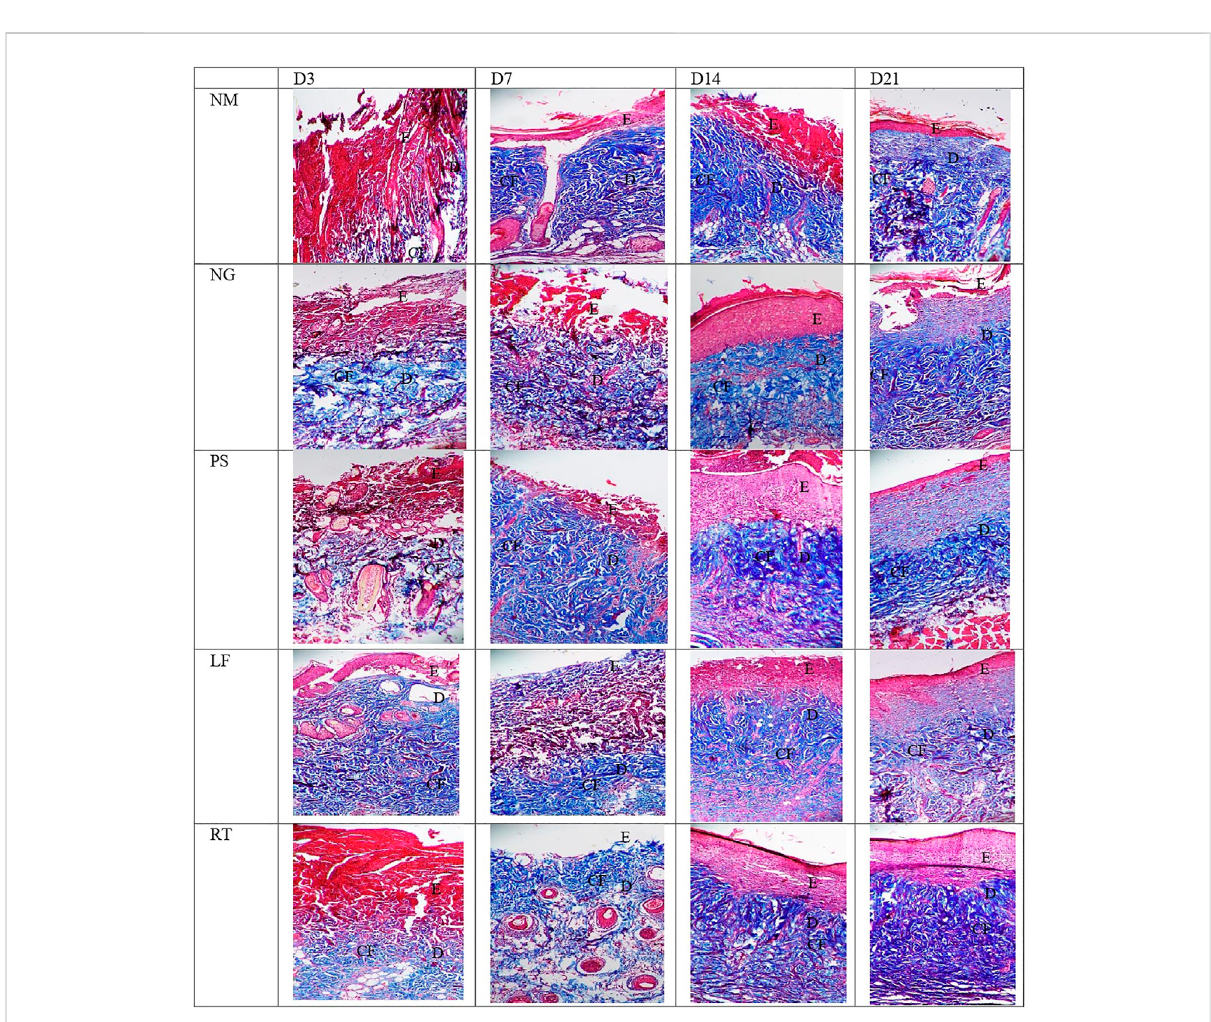
FIGURE 8 Histopathological view of the burn wounds at Day 3, 7, 14 and 21. Stained with Masson ’ s trichome staining, at ×200 magni fi cation. Collagen fi bers were stained blue, cytoplasm and erythrocyte were stained red, and nuclei were stained bluish brown. Collagen deposition of all groups